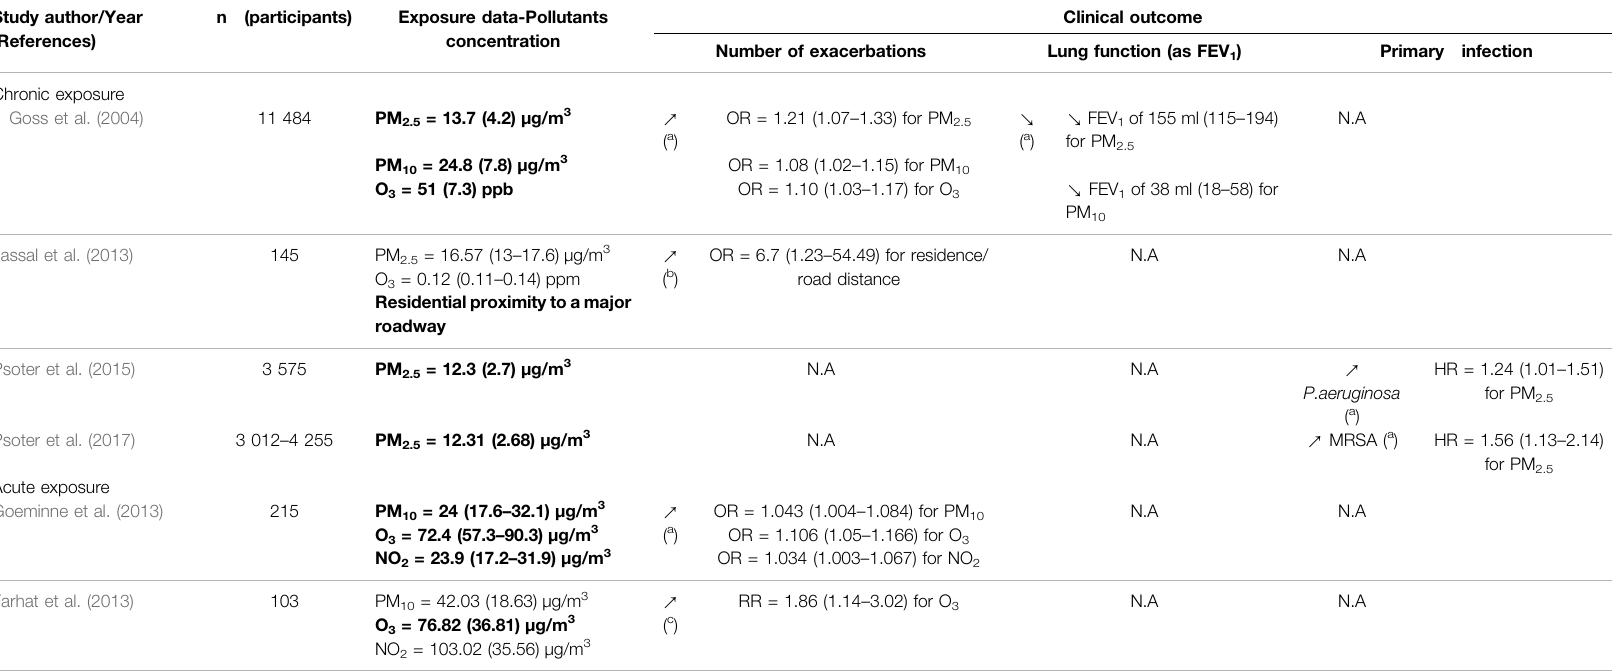
TABLE 1 | Summary and comparison of results obtained by epidemiological